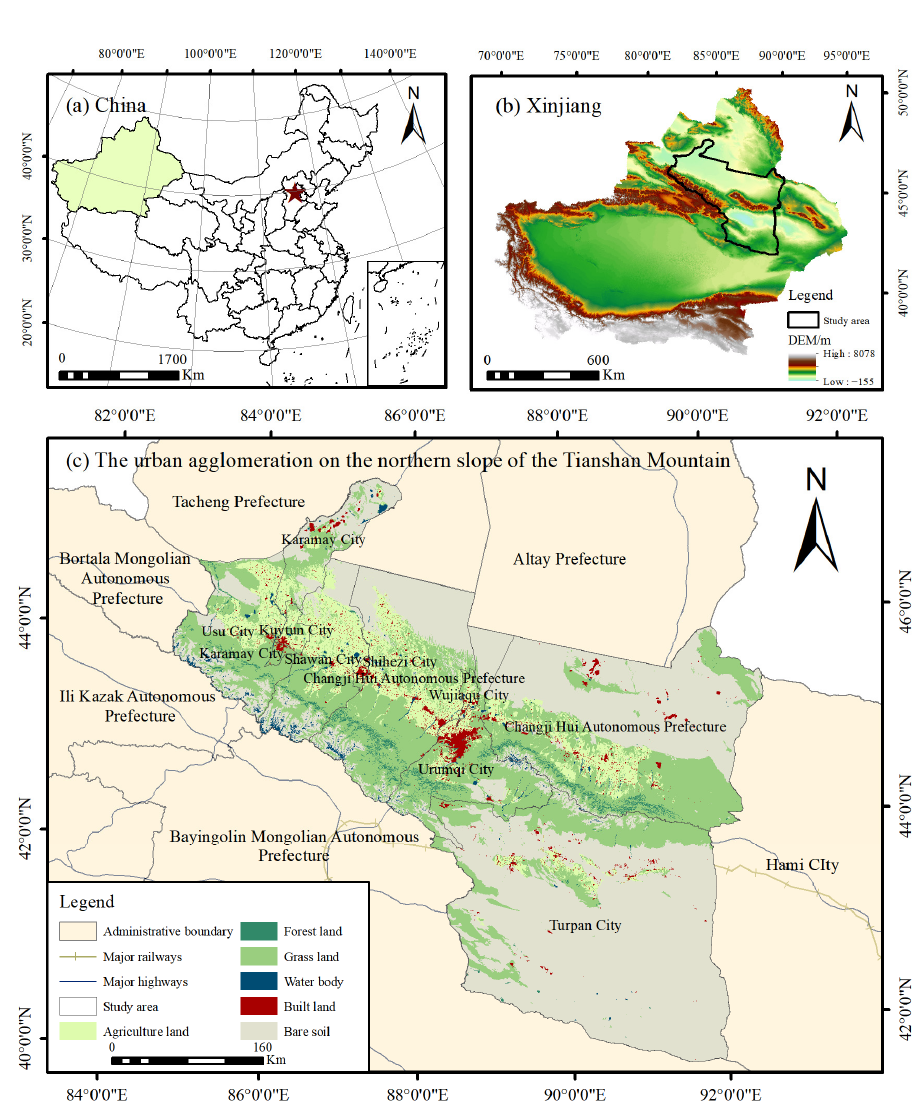
Figure 1. Location of the study area.